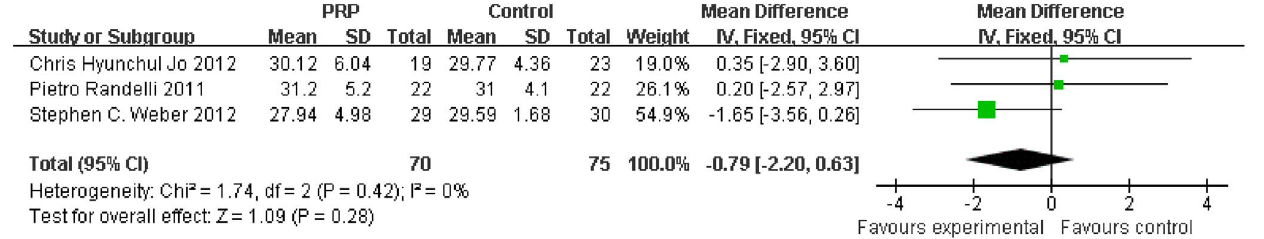
Figure 5. Difference in the UCLA scale.